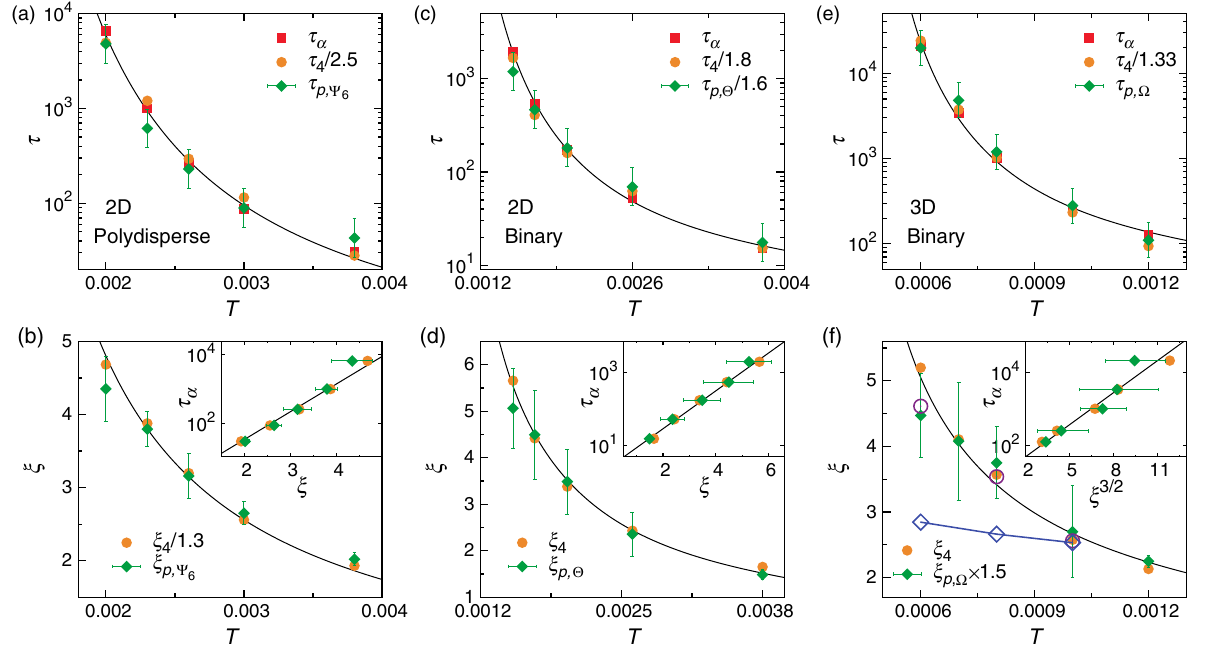
FIG. 5. Time and length scales in the structure-dynamics correlations. Left: 2D polydisperse system ( Δ ¼ 11% ). (a) Temperature dependences of the α relaxation time τ α , the timescale of dynamic heterogeneity τ 4 , and τ T 0 ¼ 8 . 6 × 10 − 4 . (b) Temperature dependences of the dynamic length scale ξ 4 and ξ − 2 =d , where d is the spatial dimension. Inset: Relationship of τ − T ξ ¼ ξ 0 ½ð T 0 Þ =T 0 (cid:2) 2 (cid:2) . (c),(d) The same analysis of temperature dependences of time and length scales as in (a) and (b) for the 2D τ ξ = ξ τ α ¼ 0 exp ½ D ð 0 Þ d= binary system with T 0 ¼ 6 . 35 × 10 − 4 . (e),(f) The same analysis of temperature dependences of time and length scales as in (a) and (b) for the 3D binary system with T 0 ¼ 3 . 5 × 10 − 4 . In addition, we include the length scales from Ref. [19] by the PTS method in (f) for a comparison: the dynamic length ξ dyn s × 1 . 75 (open circles) and the static length ξ stat × 4 . 6 (open